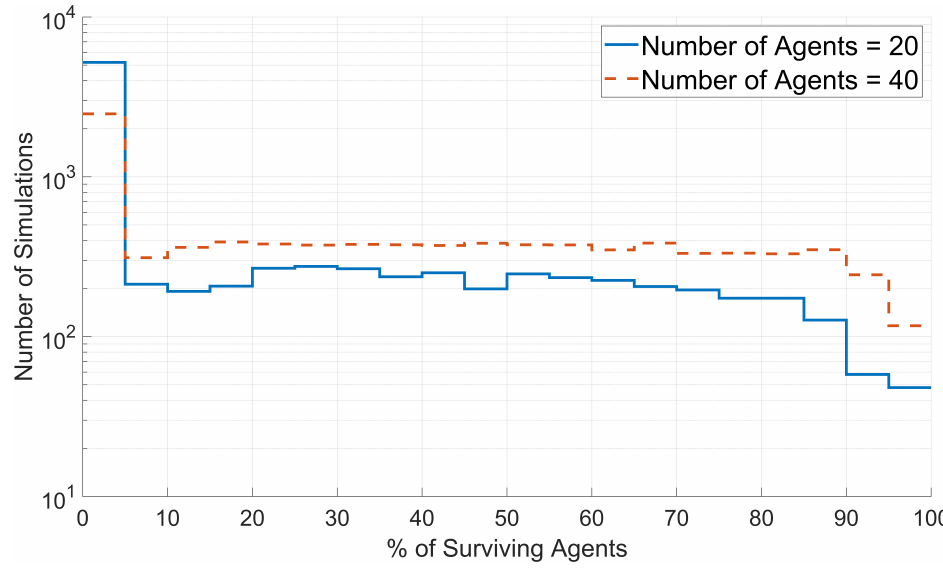
Figure 12. Distribution of swarm survival for simulations with 20 agents and 40 agents. The number of simulations for a given percentage of surviving agents is plotted on a logarithmic scale.